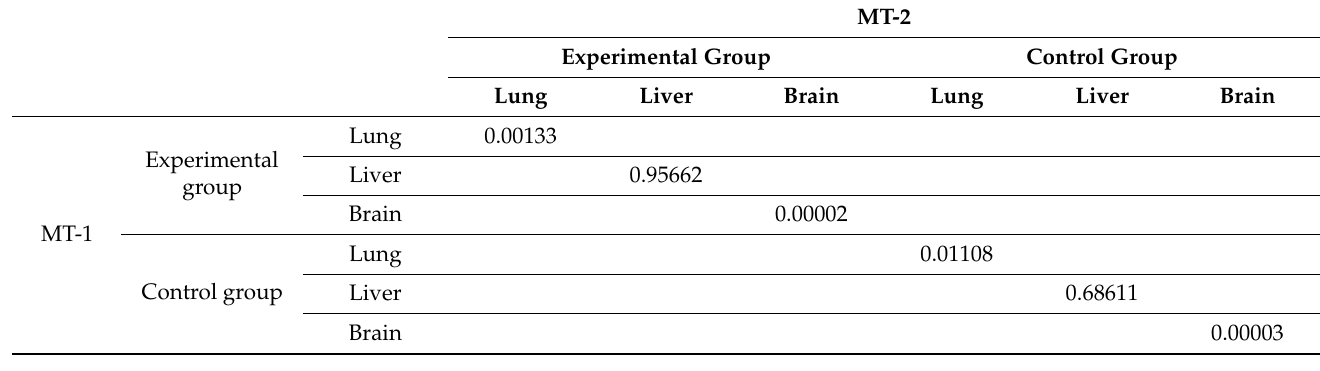
Table 3. The result of the Mann-Whitney U test for the significance of differences in the expression of MT-1 and MT2 genes in the same tissue (H2) at p < 0.01.